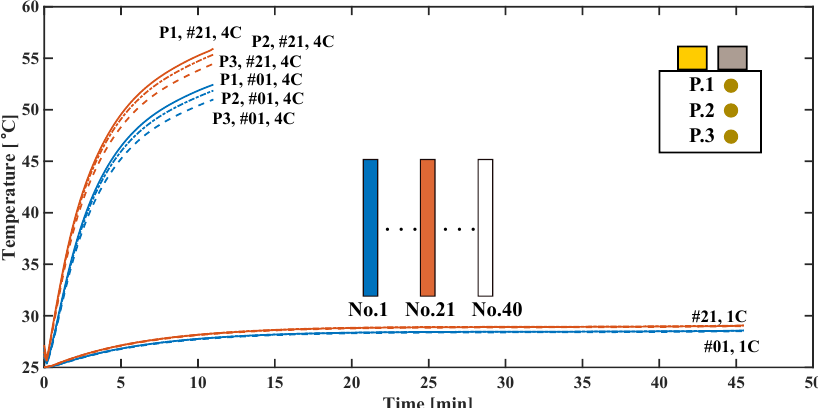
Figure 7. Evolution of local temperature ( ◦ C ) on various positions P i in layer No.1 (blue) and No.21 (red) at 1C and 4C discharge. P1: x = 36.3 mm, y = 30 mm, P2: x = 36.3 mm, y = − 15 mm, P3: x = 36.3 mm, y = − 60 mm. The original point (0,0,0) locates at the center of electro-active layers, the geometry has been shown in Figure